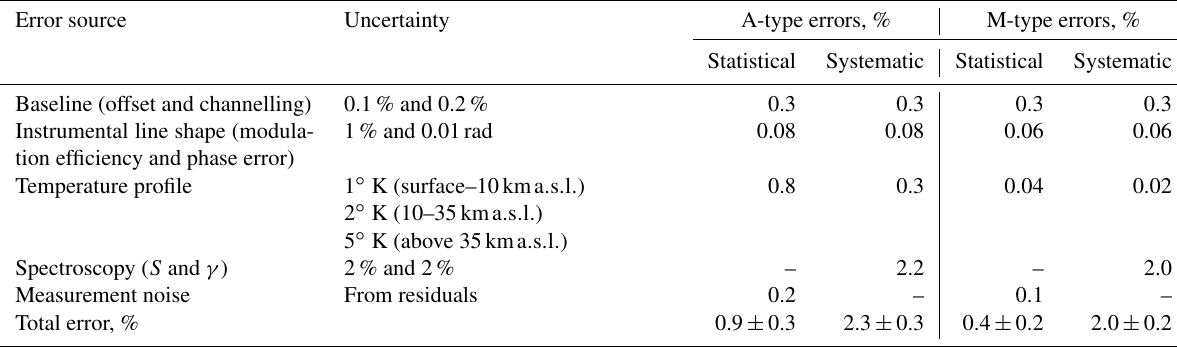
Table 2. Error budget of IWV retrieval by the FTIR